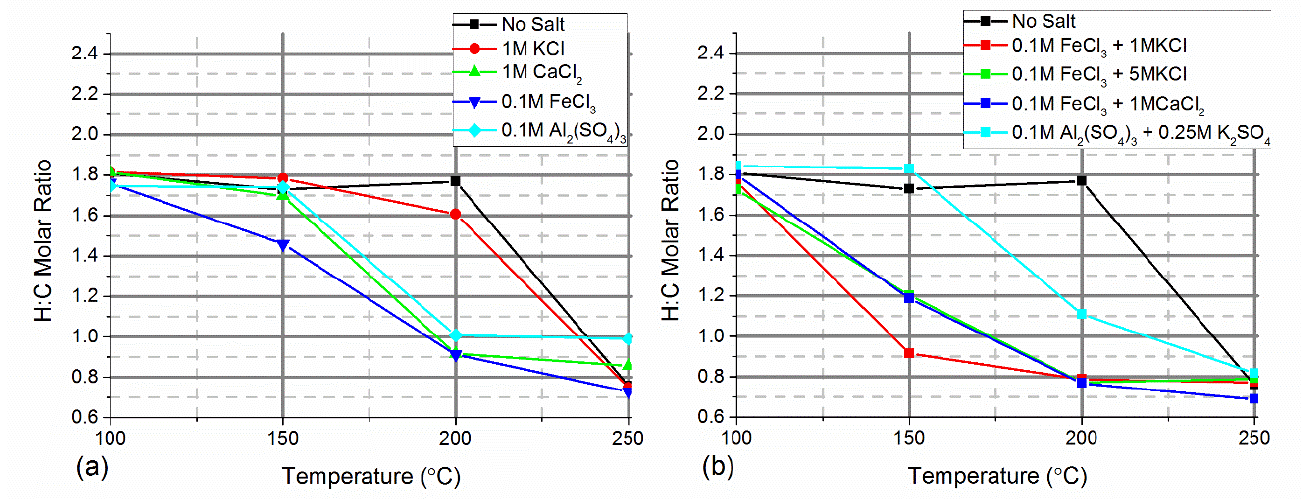
Figure 7. H:C molar ratio of hydrochars with ( a ) a single salt, and ( b ) two salts combined.